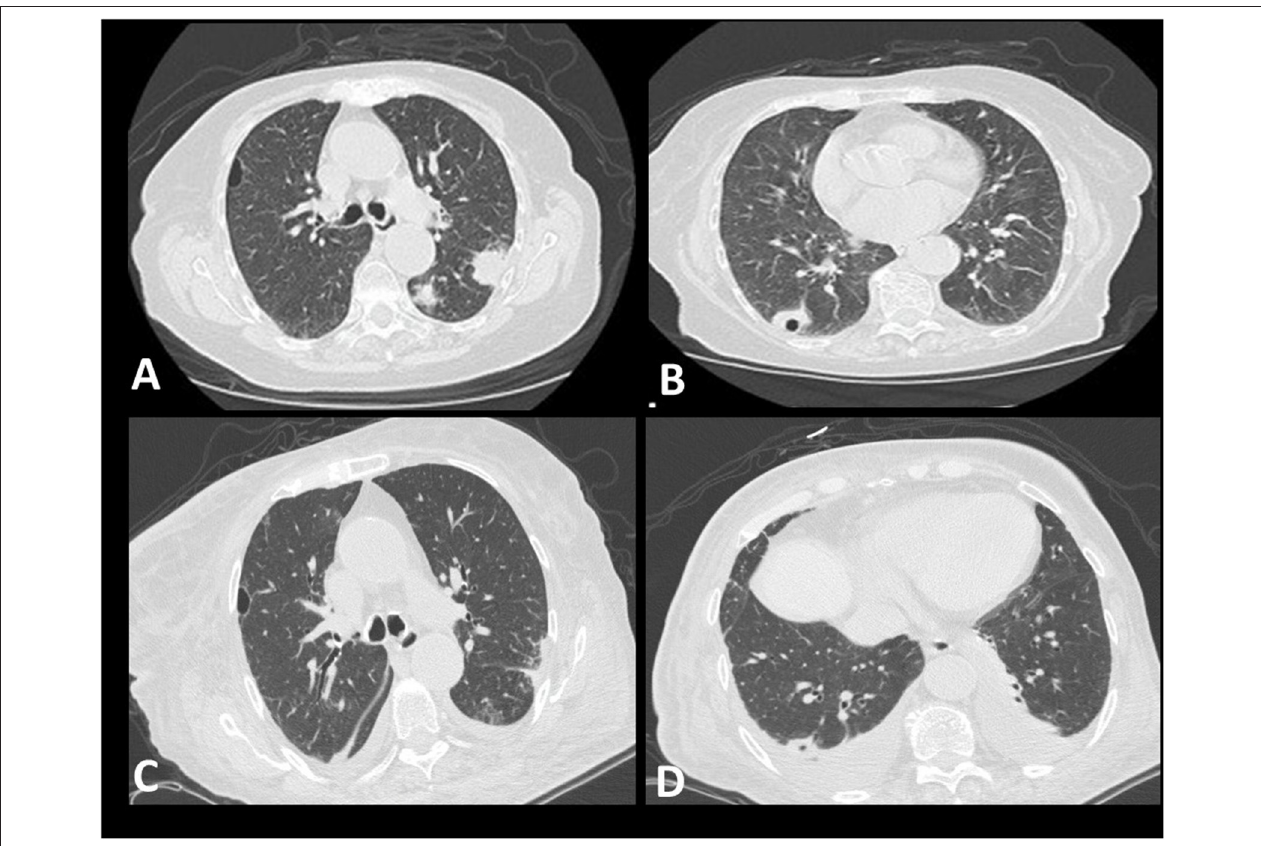
FIGURE 1 | Radiological features. (A,B) showing multifocal consolidative opacities in the left upper lobe and one cavitary lesion in the right lower lobe (A,B) (day 1). Subtle ground glass opacities across the bronchovascular bundle can also be seen (B) . Mild improvement of the radiographic appearance of the lesions is evident following treatment with pulses of methylprednisolone and cyclophosphamide (C) . Small bilateral pleural effusions are shown, indicating possible fluid overload (D)